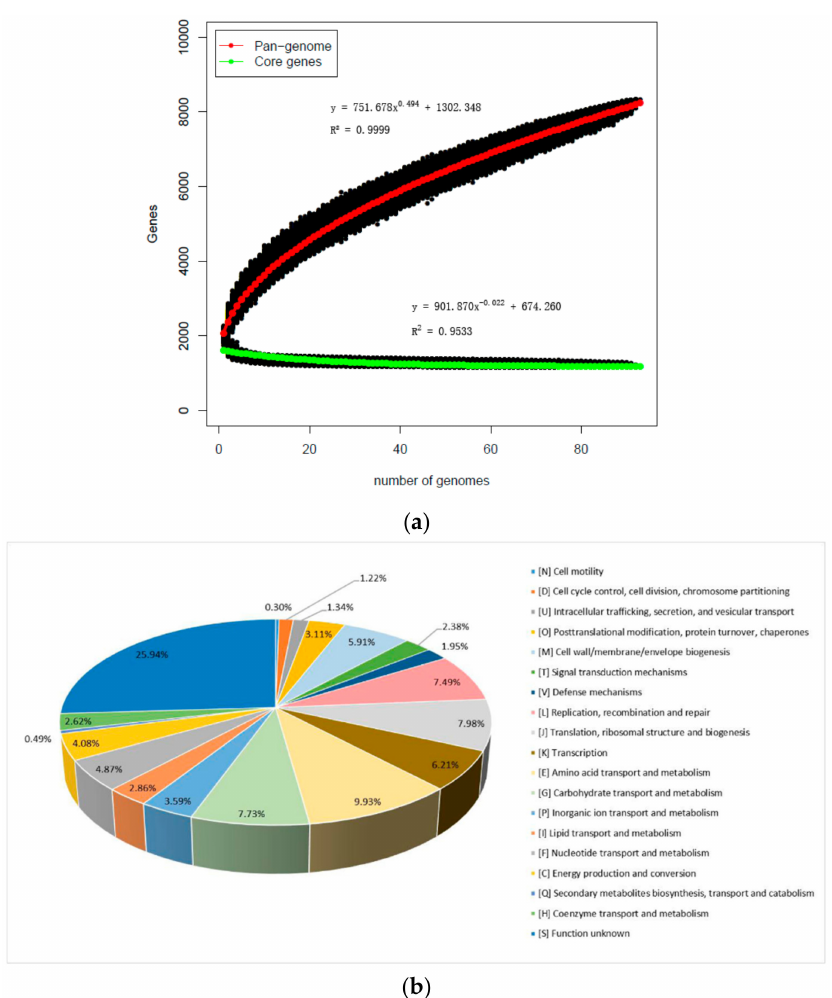
Figure 2. Pan-genome and core genes of L. mucosae : ( a ) Numbers of total features in the core (green) and pan (red) genome as a function of the number of strains sequenced. ( b ) Percentage of genes associated with general cluster of orthologous groups (COGs) of proteins’ functional